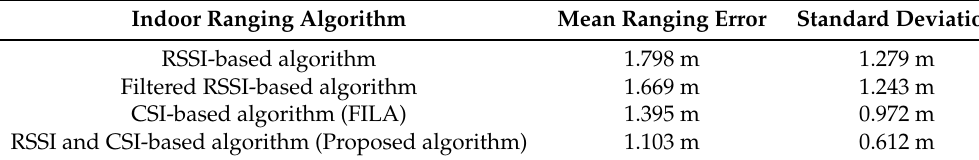
Table 4. Comparison of four indoor ranging algorithms (IT-2